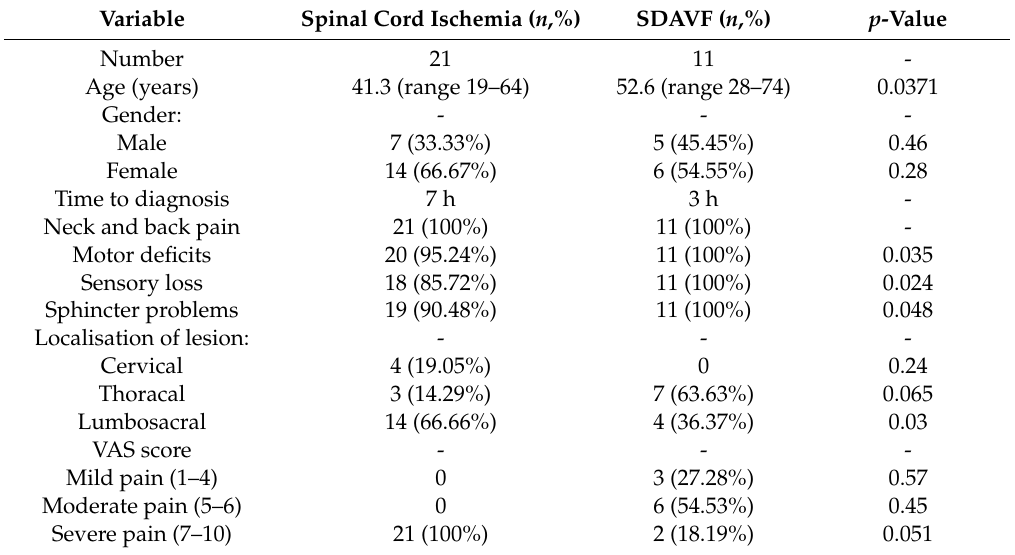
Table 1. Comparison of variables between patients with spinal cord ischemia and SDAVF.